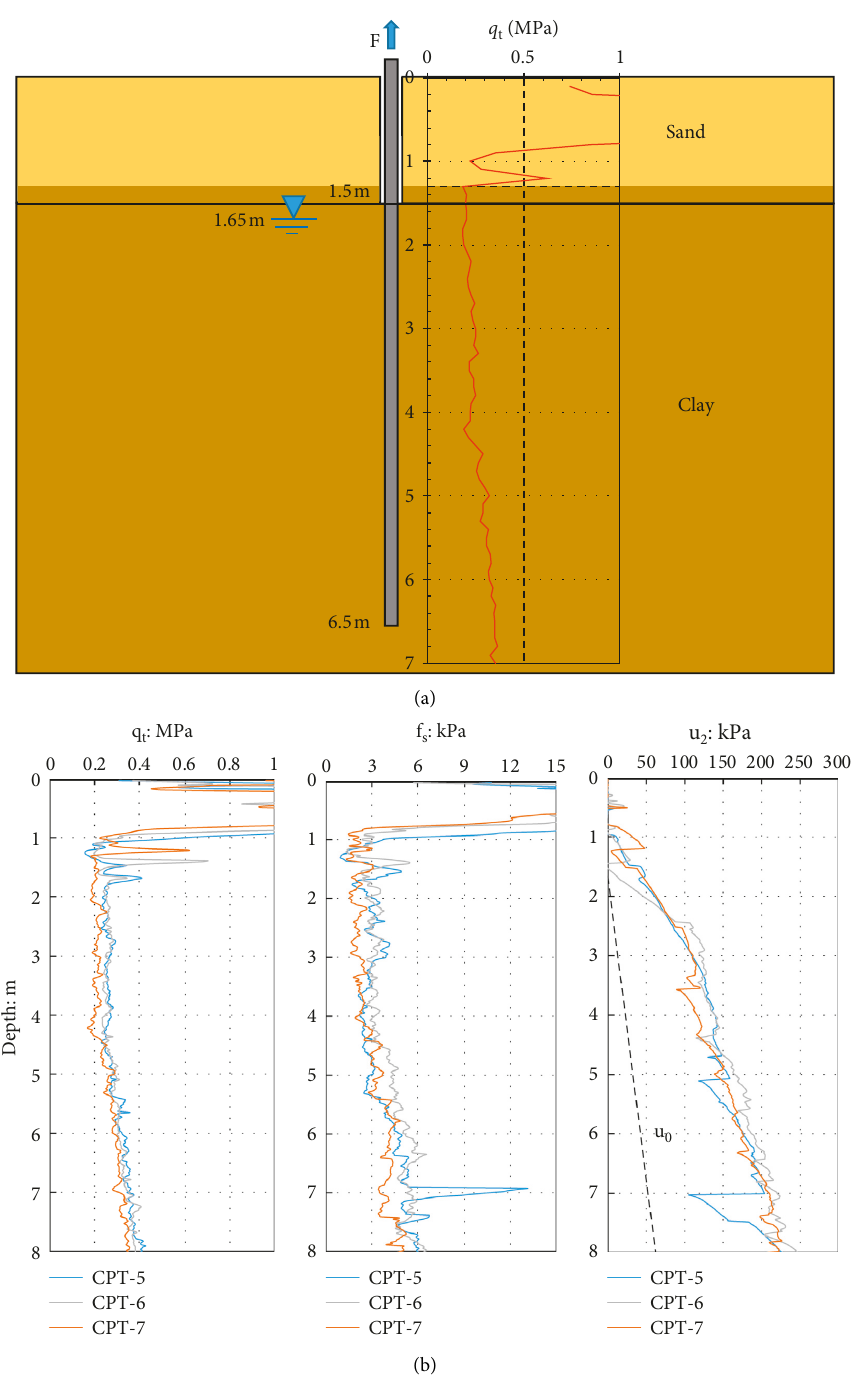
Figure 2: Geological conditions and CPT